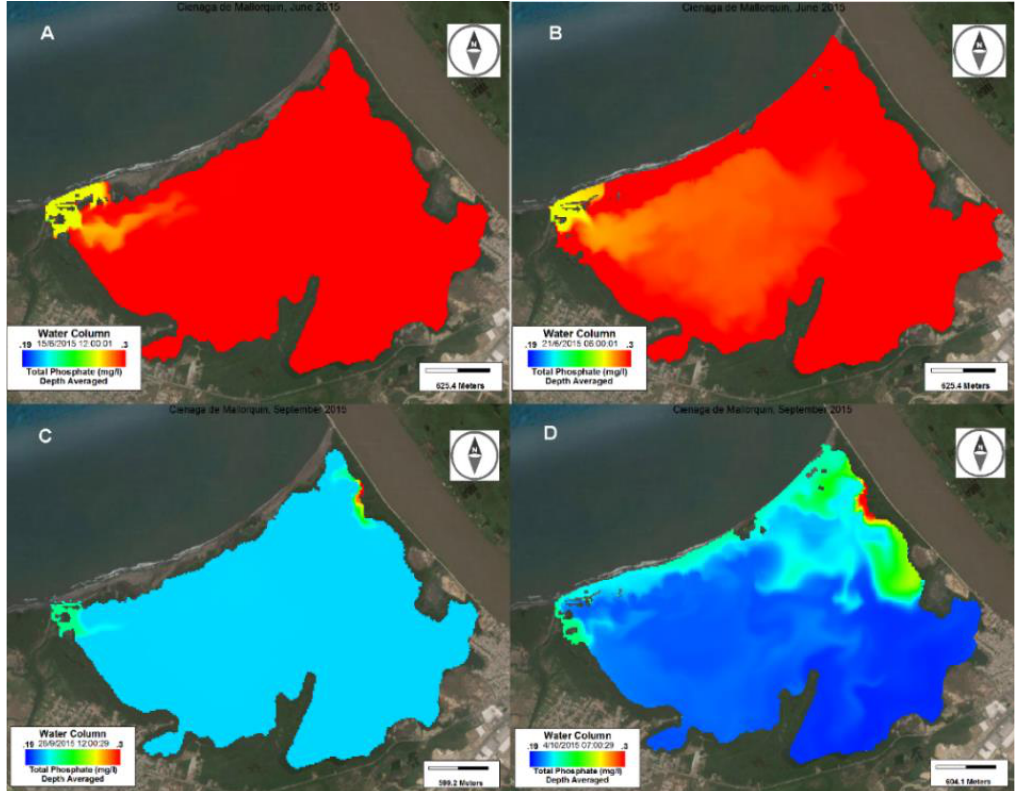
Fig. 9: Simulation of PO 4 variation. A) Transition Period (0.5 days of simulation). B) Transition Period (6 days of simulation). C) Wet season (0.5 days of simulation). D) Wet season (6 days of simulation) (wet season: note the change in scale values).